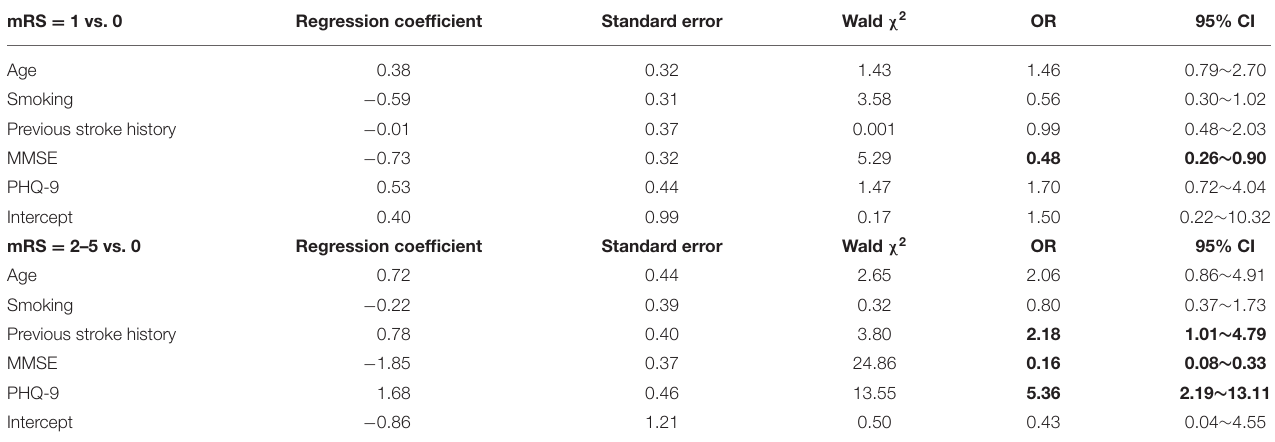
TABLE 5 | Multivariable logistic regression analysis among patients with different mRS groupings. mRS = 1 vs.